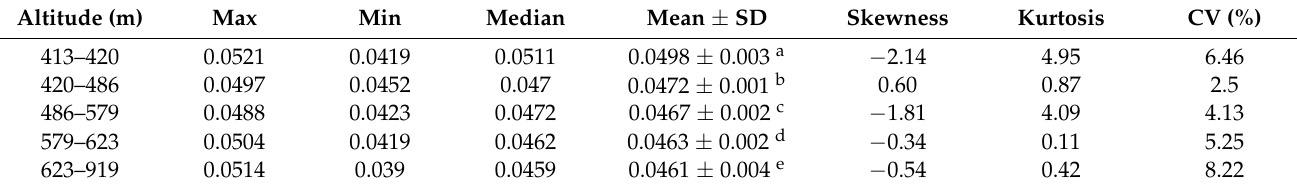
Table 6. Statistics of K values at different altitudes (t·hm 2 ·h/(hm 2 ·MJ·mm)).